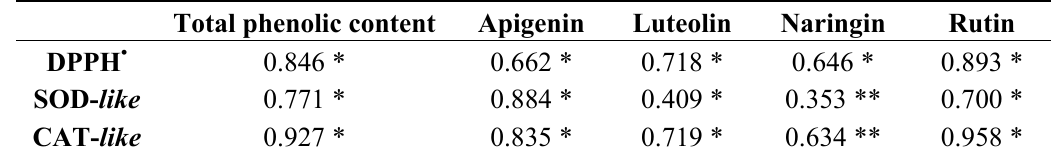
Table 4. Pearson correlations between phenolic compounds of Lippia alba accessions